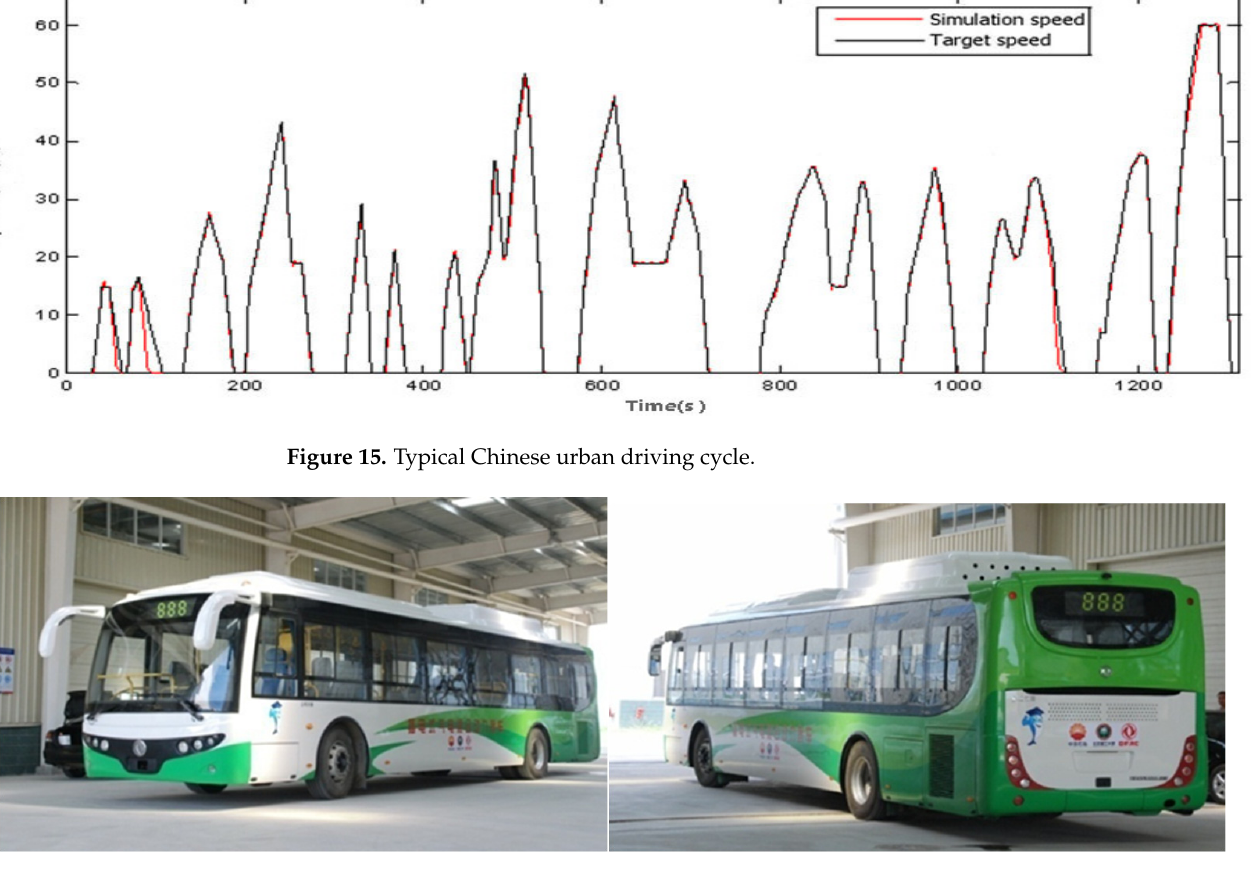
Figure 16. Hybrid electric vehicle. Table 3. Vehicle technical